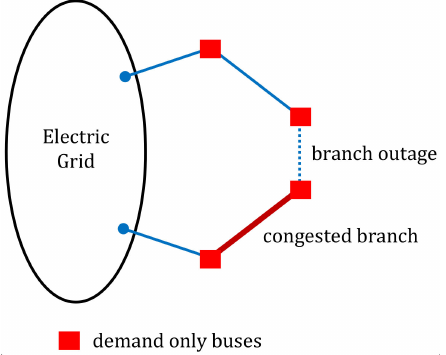
Figure 3. Network topology divergence of the algorithm